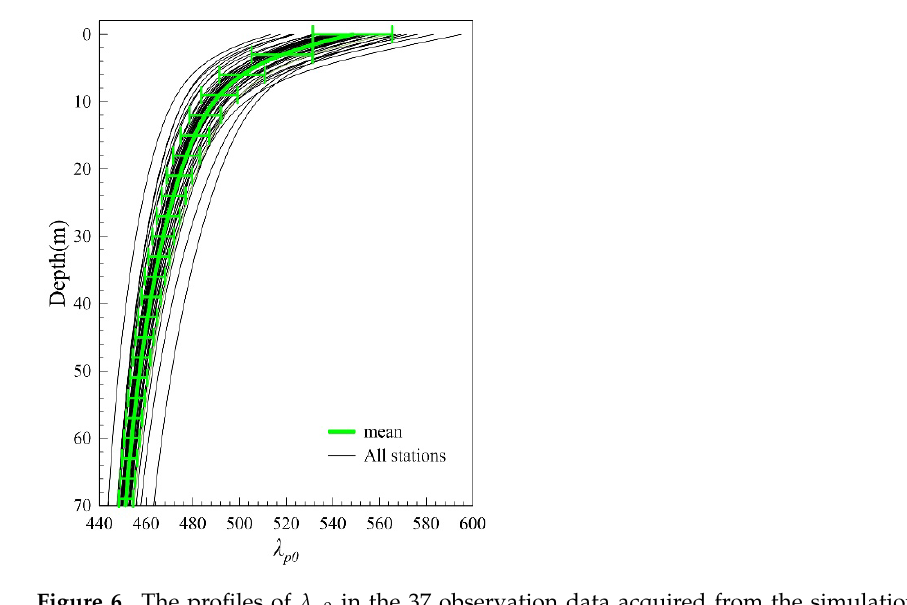
Figure 5. The fitting relationship between the deviation of λ p (relative to the ideal λ p 0 in pure seawater) and the integrated chlorophyll- a concentration according to Equation (25) ( A ) and Equation (26) ( B ), respectively.